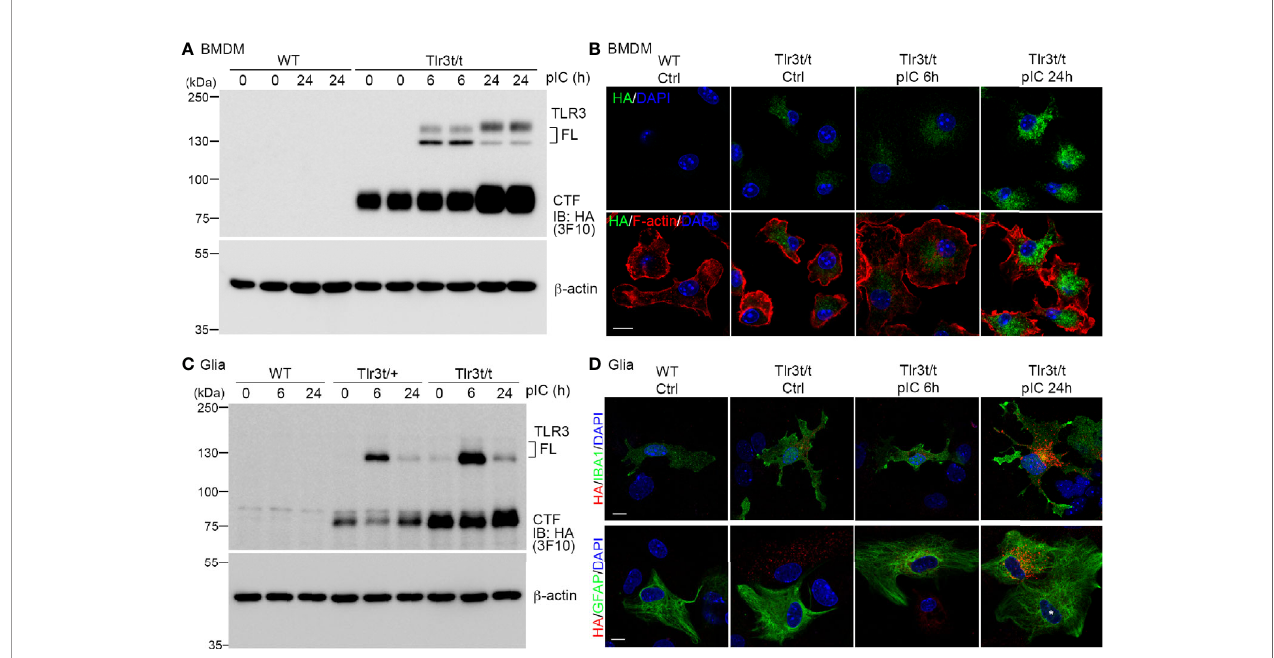
FIGURE 4 | Poly(I:C) stimulation increased endogenous TLR3-MH protein level in Tlr3 t/t cells. (A, C) Immunoblot analysis of TLR3 proteins in BMDMs (A) and glia cells (C) , as indicated. WT, Tlr3 t/+ and Tlr3 t/t cells were treated with poly(I:C) or vehicle control. After different incubation times, cell lysates were harvested and analyzed using anti-HA (3F10) and b -actin antibodies (loading control). FL, full-length TLR3; CTF, C-terminal fragment of TLR3. (B, D) Immuno fl uorescence staining to monitor TLR3 expression in BMDMs (B) and glia cells (D) of WT and Tlr3t/t mice with or without poly(I:C) treatment. Anti-HA antibodies (C29F4 in (B, D) lower panel, or 16B12 in (D) upper panel) were used for dual immunostaining with cell markers. F-actin was used to outline BMDM morphology. IBA1 is a microglia marker. GFAP is a marker for astrocytes. Nuclei were counter-stained with DAPI. Scale bar, 10 m